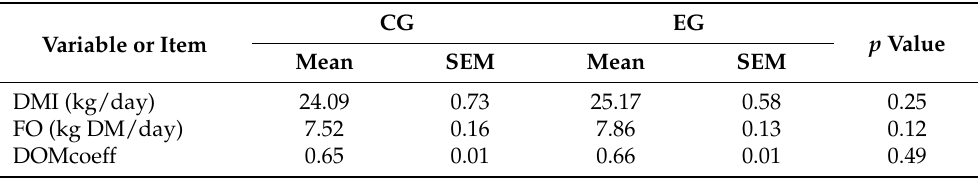
Table 2. Mean values ± SEM for dry matter intake, fecal output and diet digestibility of dairy cows grouped by low (CG) or high (EG) locomotion score.